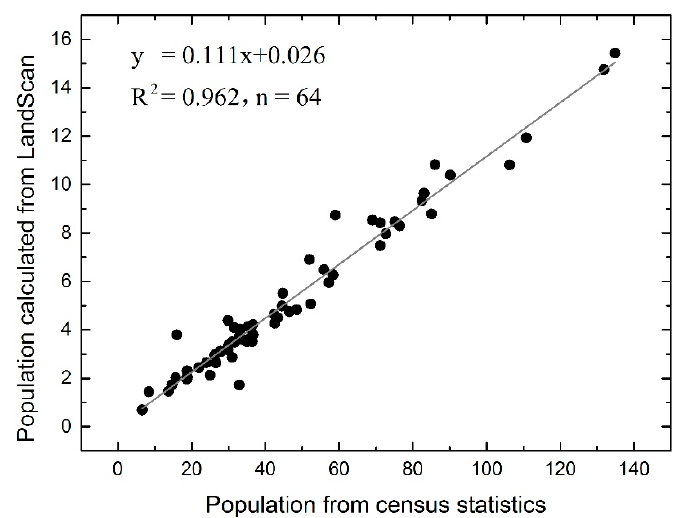
Figure 5. Comparison of total population of each county in Landscan and statistical yearbook. The horizontal axis is the total population at the end of 2015 (ten thousand people), and the vertical axis is the zonal statistics from Landscan after normalization to 0–1.